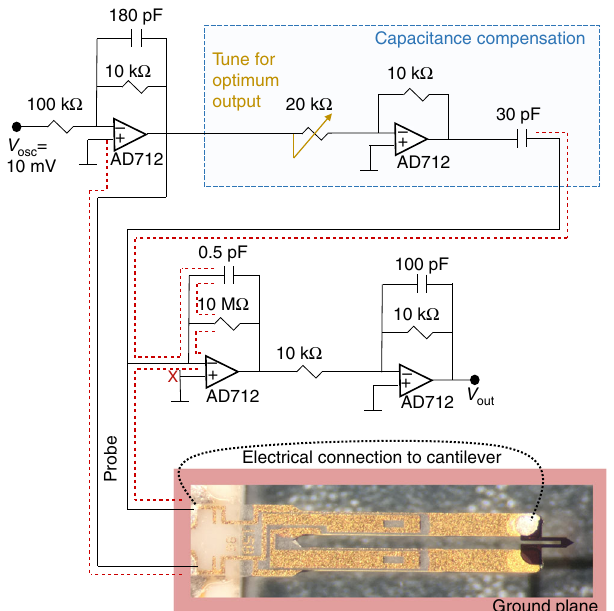
Fig. 8 Detection circuit. Schematic diagram of the electrical circuit including necessary capacitance compensation elements, ampli fi cation, and placement of the A-Probe 30 in the circuit. The output from the capacitance compensation line is inverted and summed with the measured response of the cantilever to detect only the piezoelectric current due to the lever motion at resonance. To reduce noise, the braided shield of a low- capacitance twisted pair directly connects to the positive input of the operational ampli fi ers AD712, and to a ground plane directly below the vibrating lever. Our design is a modi fi cation based on that developed by NANOSENSORS ™ 30,45